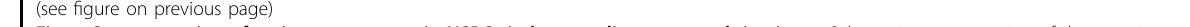
Fig. 1 Overexpression of various oncogenes in HSPCs induces malignant growth in vivo. a Schematic representation of the experimental procedure. BM of CD45.2 rtTA mice sorted to obtain HSPCs. Candidate oncogenes were introduced in batches. Cells were transplanted into congenic mouse. FACS analysis of peripheral blood (PB) revealed the appearance and progression of leukemia. Passage into secondary and tertiary recipients established these models. b – f Representative FACS pro fi les of cells from the PB of ML23. Increased fraction of CD45.2 + ZsGreen + ( b , c ). Increase in Mac1 + ( d ), not in CD3e or B220 or e , f Same donor cells transduced with control-LV shown to yield no malignant growth ( g ). Data shown from one out of at least three independent